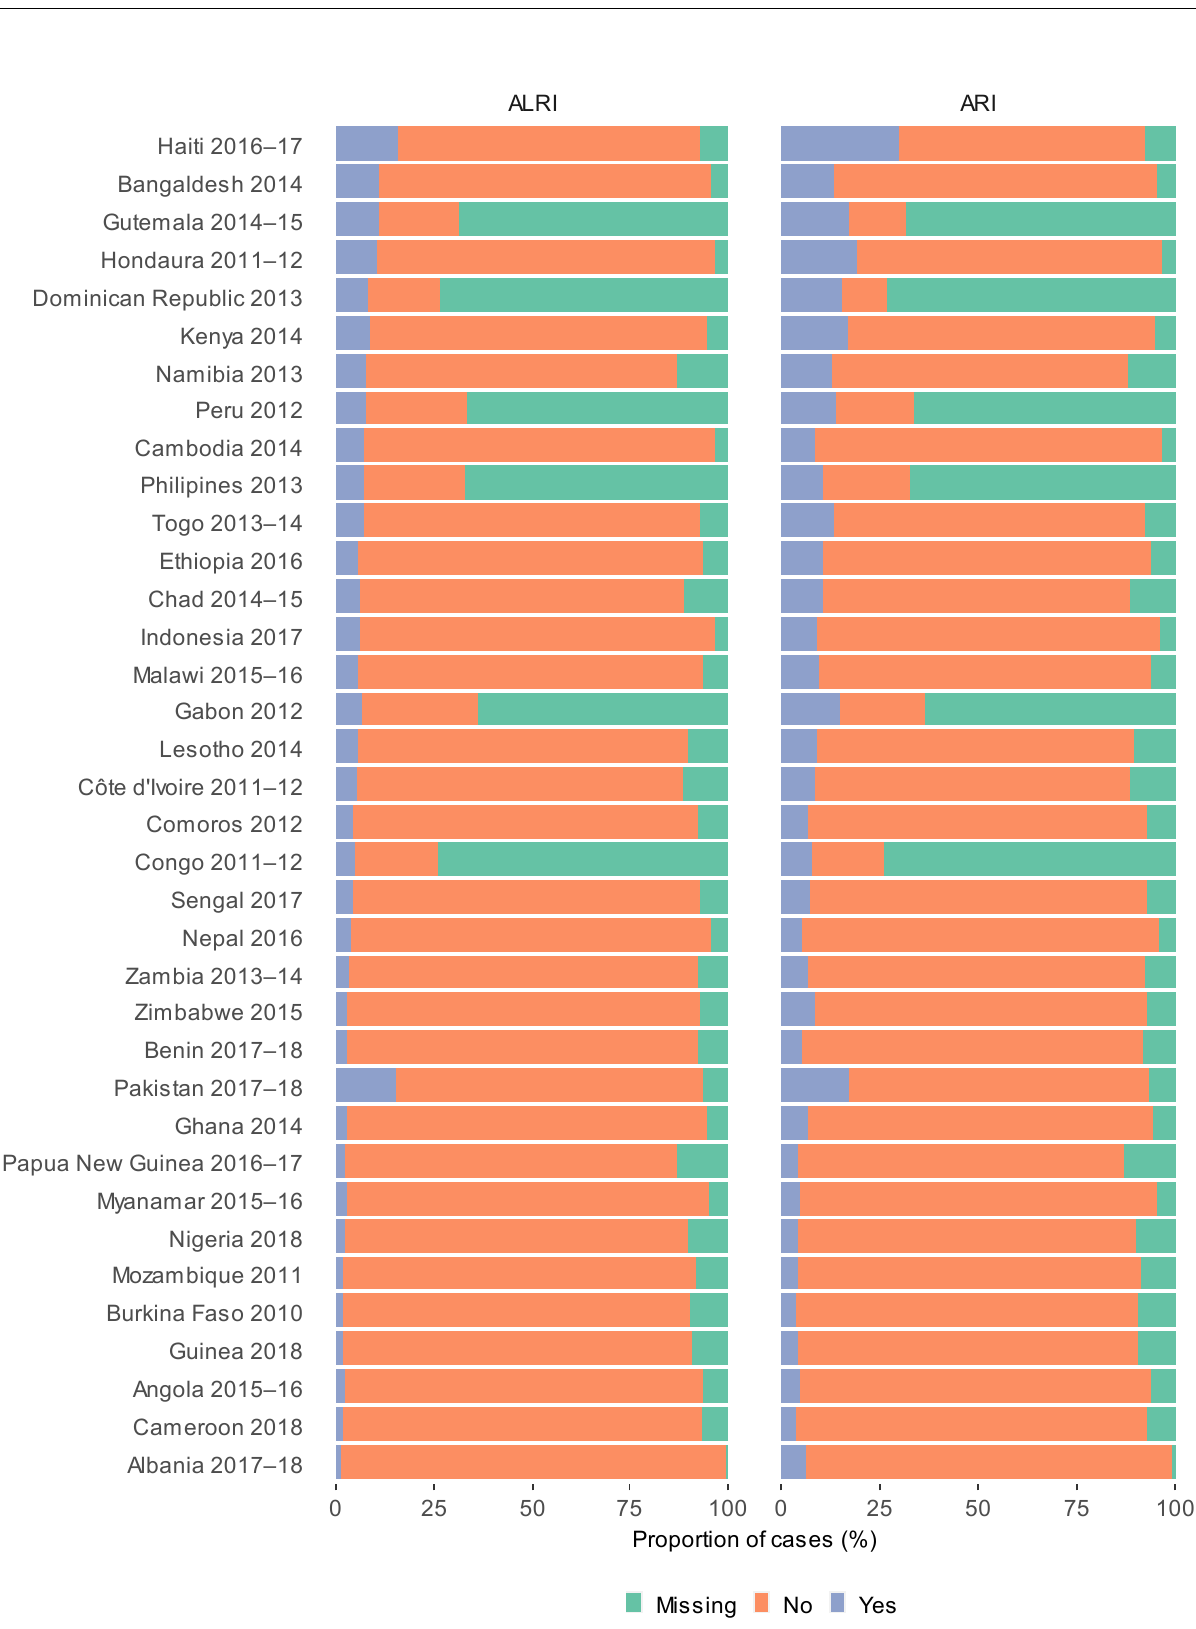
Figure 4. Proportion of ARI and ALRI cases in children under five by country.